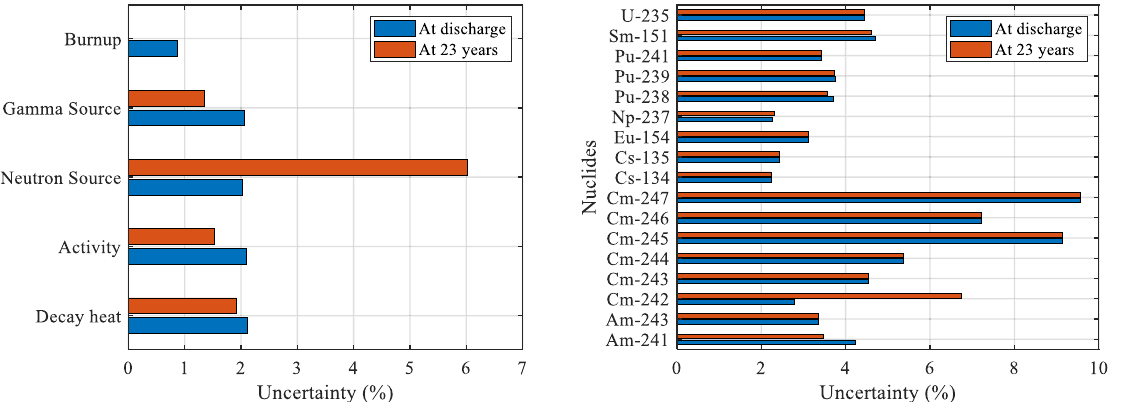
Figure 1. Uncertainties of source terms and nuclides due to modeling